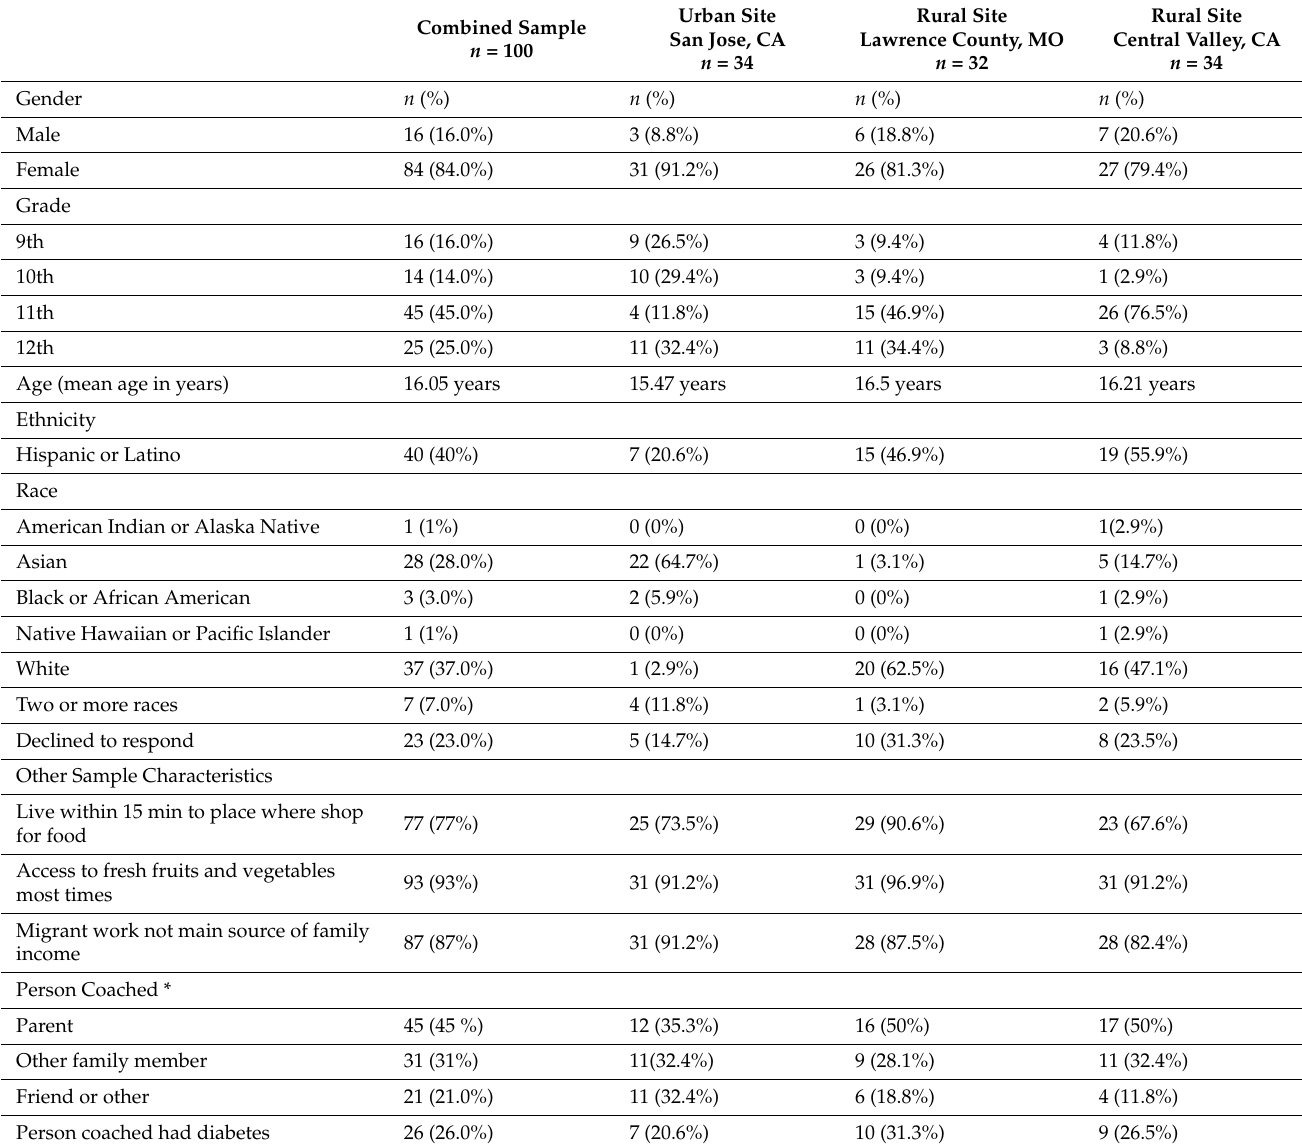
Table 2. Demographic characteristics of all participants ( n = 100) combined and by location (San Jose, CA; Lawrence County, MO; and Central Valley, CA),